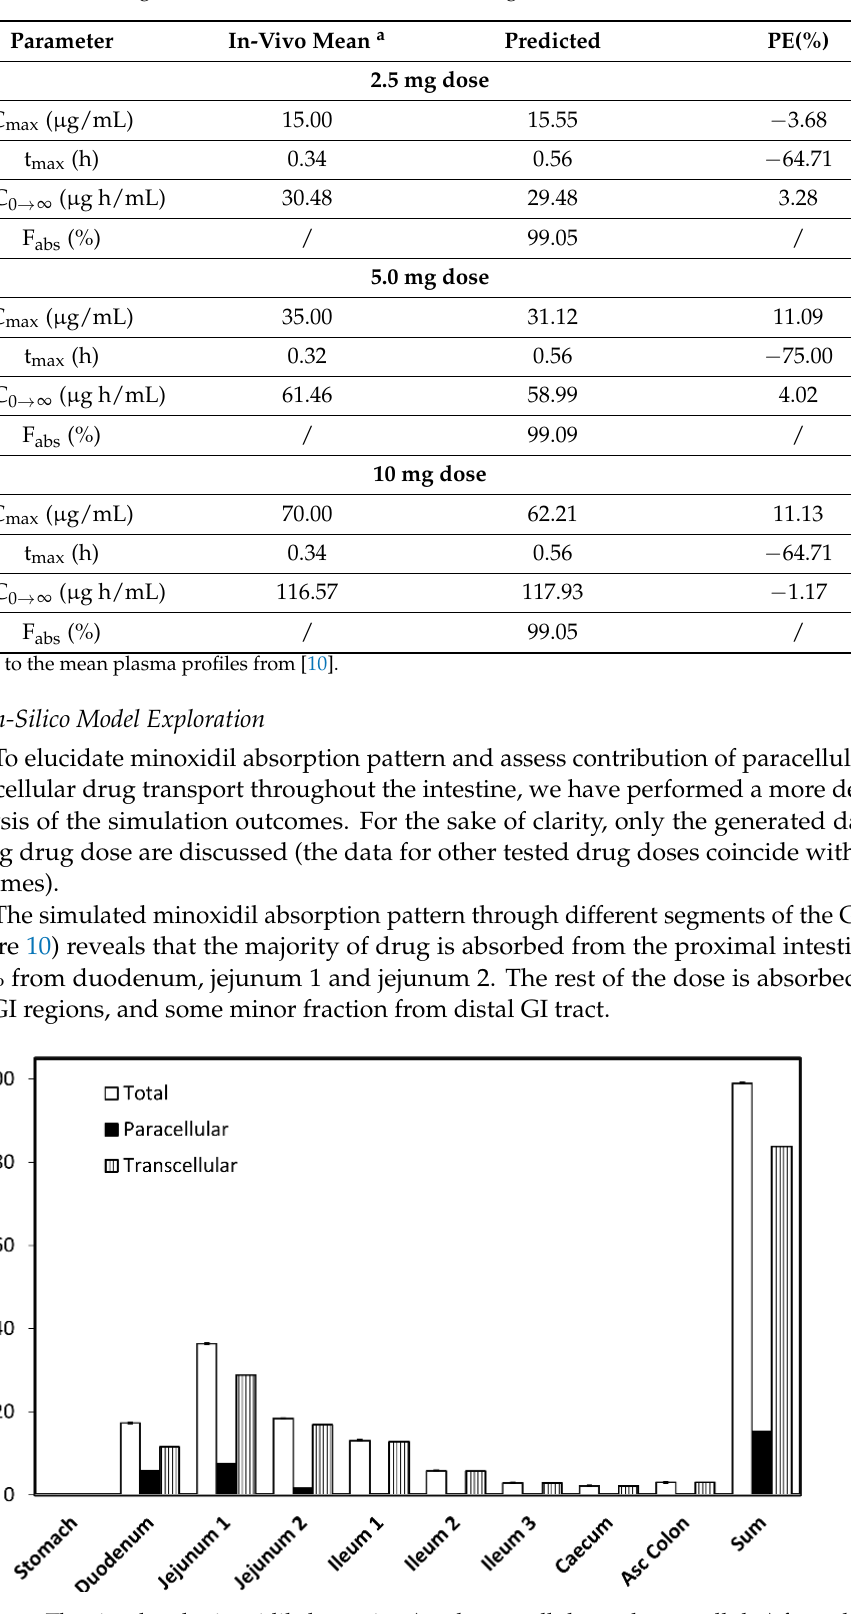
Figure 10. The simulated minoxidil absorption (total, paracellular and transcellular) from different regions in the human gastrointestinal (GI) tract.